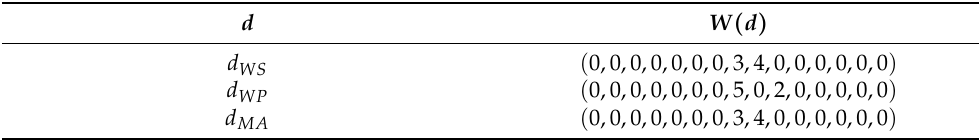
Table 1. W ( d ) of d WS , d WP and d MA .